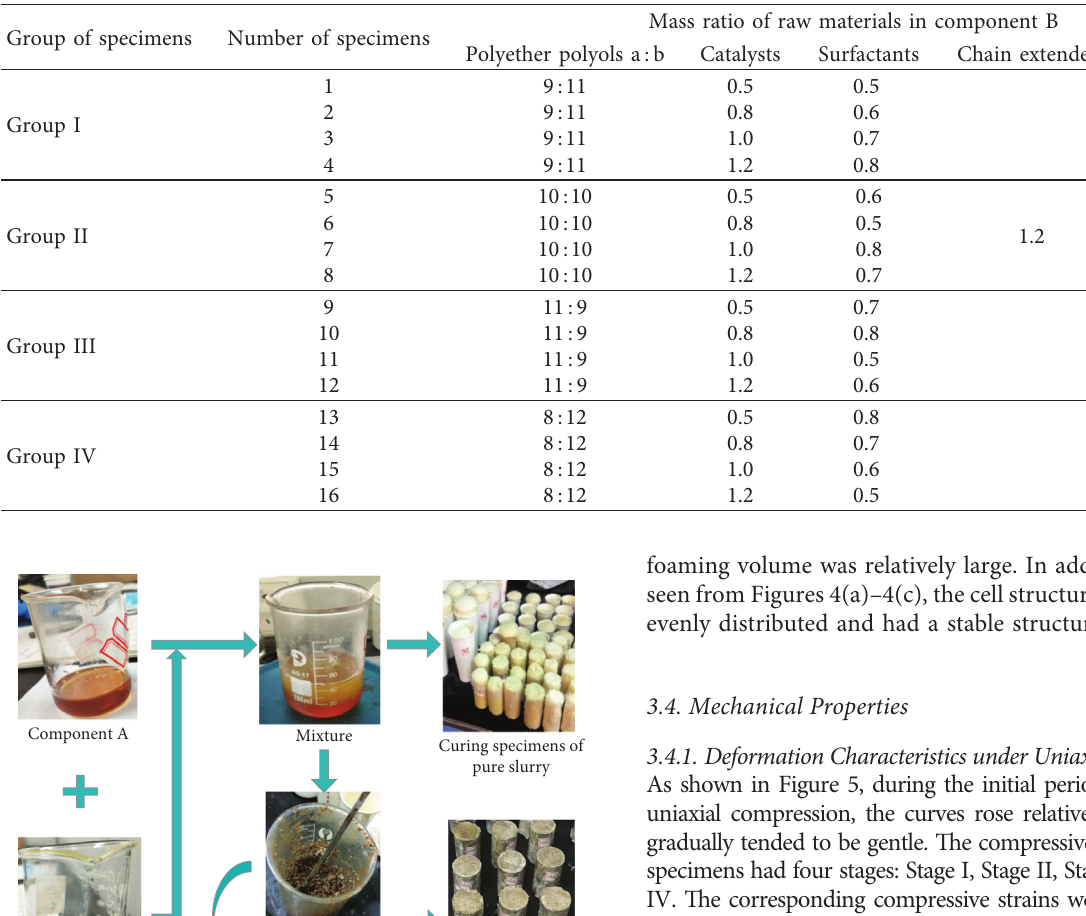
Table 3: Proportioning schemes of component B.